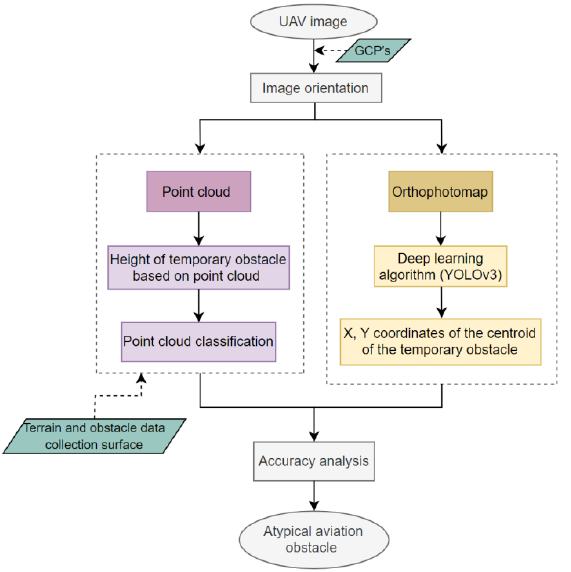
Figure 1. The scheme of detection of the atypical aviation obstacles.